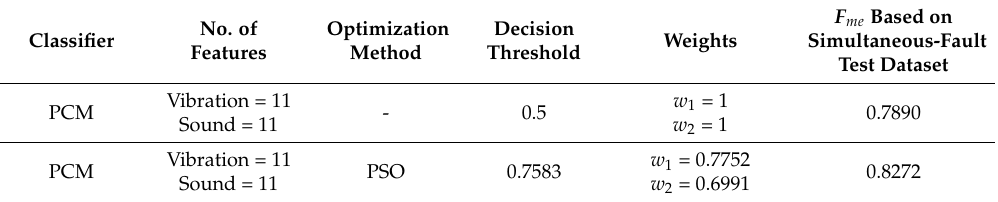
Table 9. Selection of optimal weights and decision threshold using